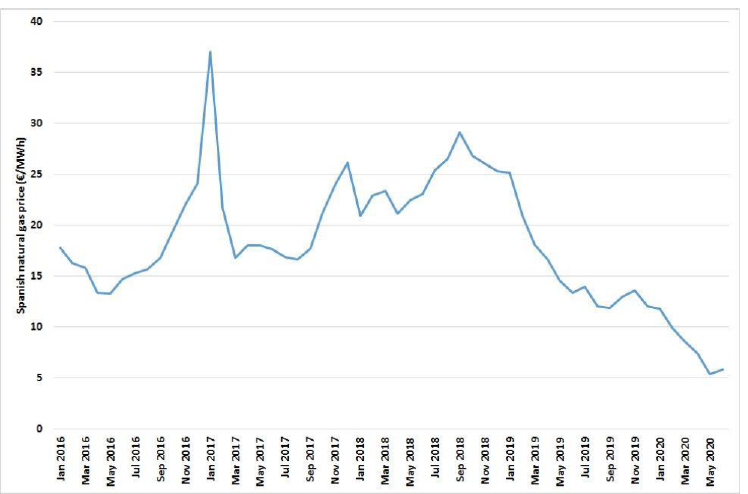
Figure 2. Spanish monthly natural gas prices, from January 2016 to June 2020. Source: own work based on Iberian gas market (MIBGAS)